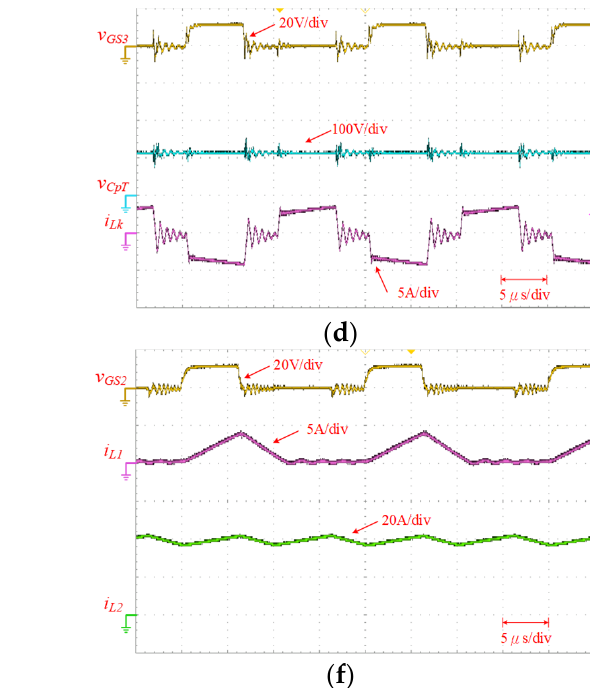
Figure 26. The experimental waveforms for the proposed IBAHB measured at a load of 200W: ( a )